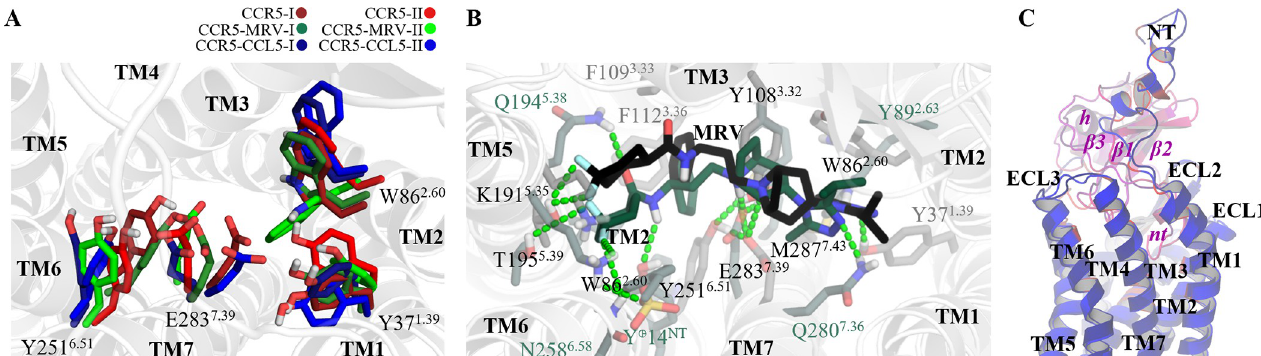
Fig 3. Orthosteric site of CCR5. Representative configuration of the OSS of the (A) three systems with replicates and complexes with (B) MRV and (C) CCL5. In the clustered configurations, the main interactions are the saline bridge between the tropane moiety with E283 7.39 or Y108 3.32 , the ion-dipole E283 7.39 with Y251 6.51 or with Y108 3.32 , the hydrogen-bond between the triazole ring and Y37 1.39 , the aromatic interaction triazole-W86 2.60 , the interaction between at least one fluor atom and T195 5.39 , the aromatic interactions among the phenyl group of MRV and F109 3.33 and F112 3.36 , and the hydrogen-bond between the ligand amide and Y251 6.51 . The interactions receptor-chemokine include the NT and all the TMs helices but TM4, as well as ECL2 and ECL3. The most variable contacts are those that are located within the NT due to its inherent higher mobility. The regions in CCL5 indicated in lowercase and italic text labels include the most extended peptide fragment except for helix ( h ). Despite its disordered segments, the unfolded residues of CCL5 do not exhibit greater motions than the NT of the receptor. The detailed contacts of CCL5 with CCR5 are presented in S3